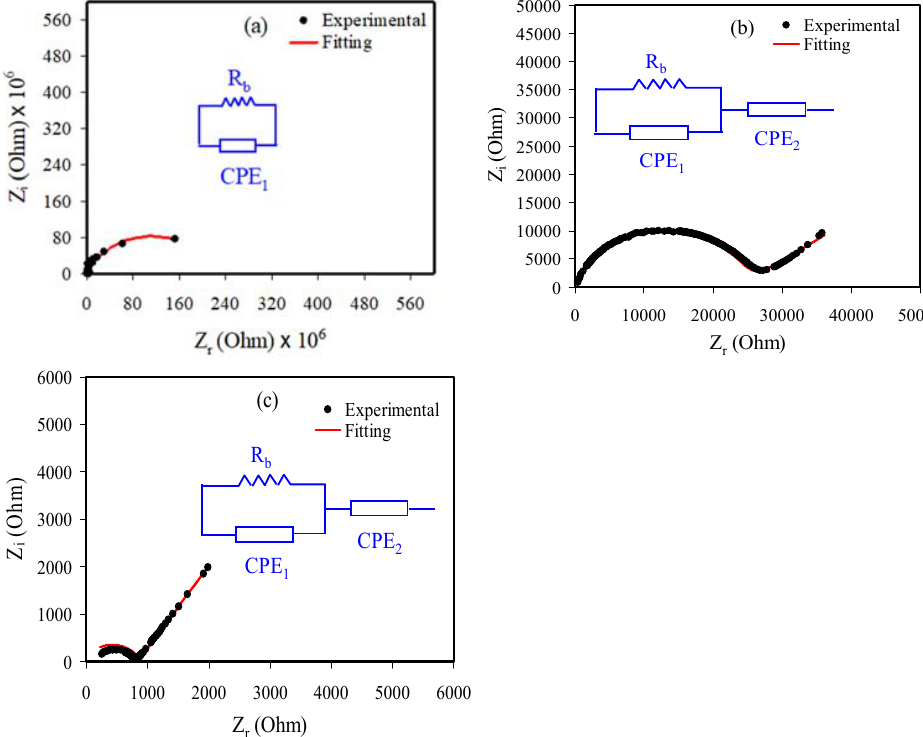
Figure 3. EIS for ( a ) PVA, ( b ) PSP_1, and ( c ) PSP_2at room temperature (RT). Table 2. The EEC fitting parameters for PVA, PSP_1, and PSP_2 at RT.